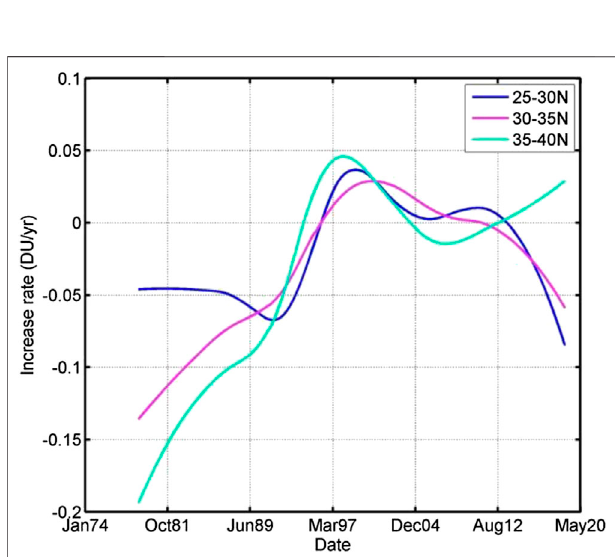
FIGURE 3 | EEMD-based decomposition of TCO from MOD/NASA over 30 ° N – 35 ° N latitudinal zone.